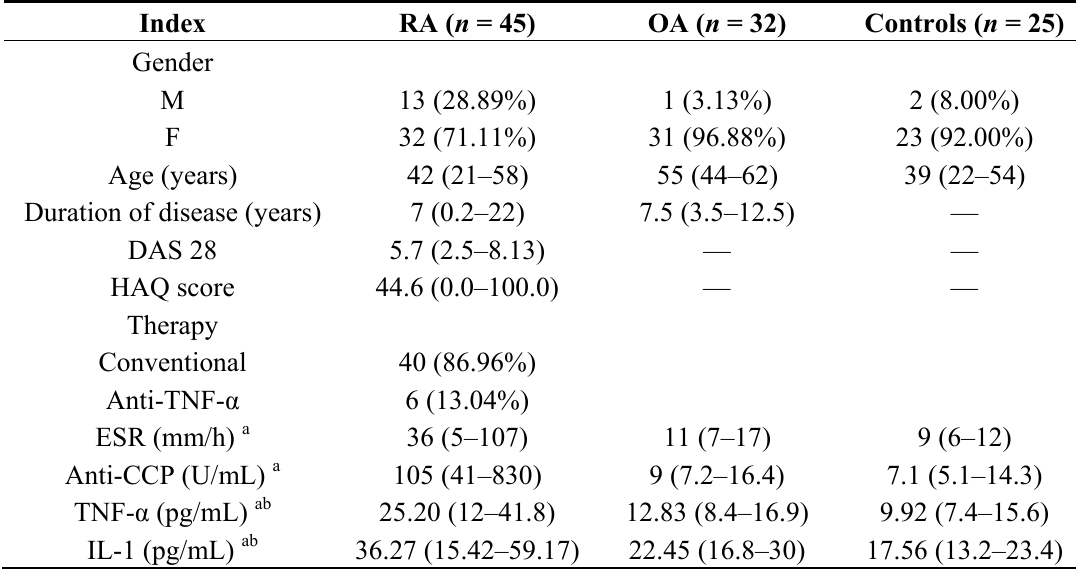
Figure 1. miR-155 upregulation correlates with increased production of TNF- α and IL-1 β in Rheumatoid arthritis (RA) patients. ( A ) and ( B ): Increased expression of TNF- α and IL-1 β in RA plasma. Results are expressed as pg/mL by an ELISA test; ( C ): MiR-155 is upregulated in PBMCs of active RA patients. Results in patients with RA ( n = 45) and OA